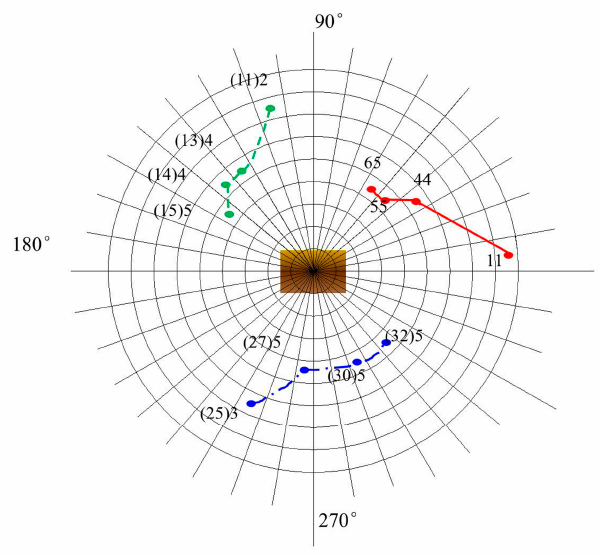
Figure 12. Three-view optimal observation paths.